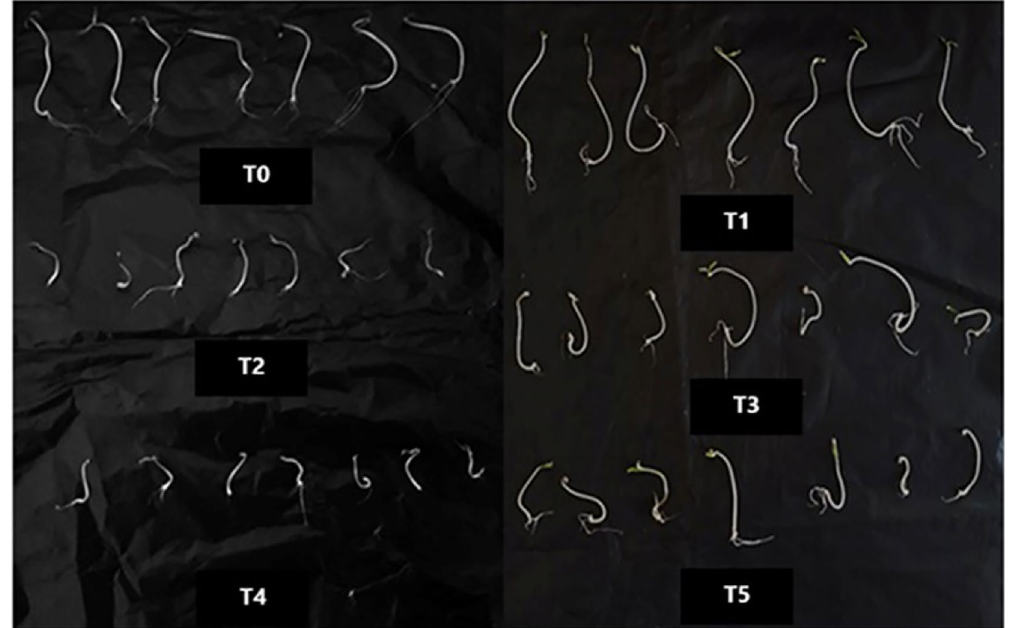
Fig. 4 Photographs of tomato seedlings showing the differences between control and salt stressed seedlings under T. viride fungal application. T 0 , T 2 and T 4 represent tomato seedlings grown on MS medium under 0, 50 and 100 mM NaCl stress, while T 1 , T 3 and T 5 represent tomato seedlings grown on MS medium with T. viride under 0, 50 and 100 mM NaCl